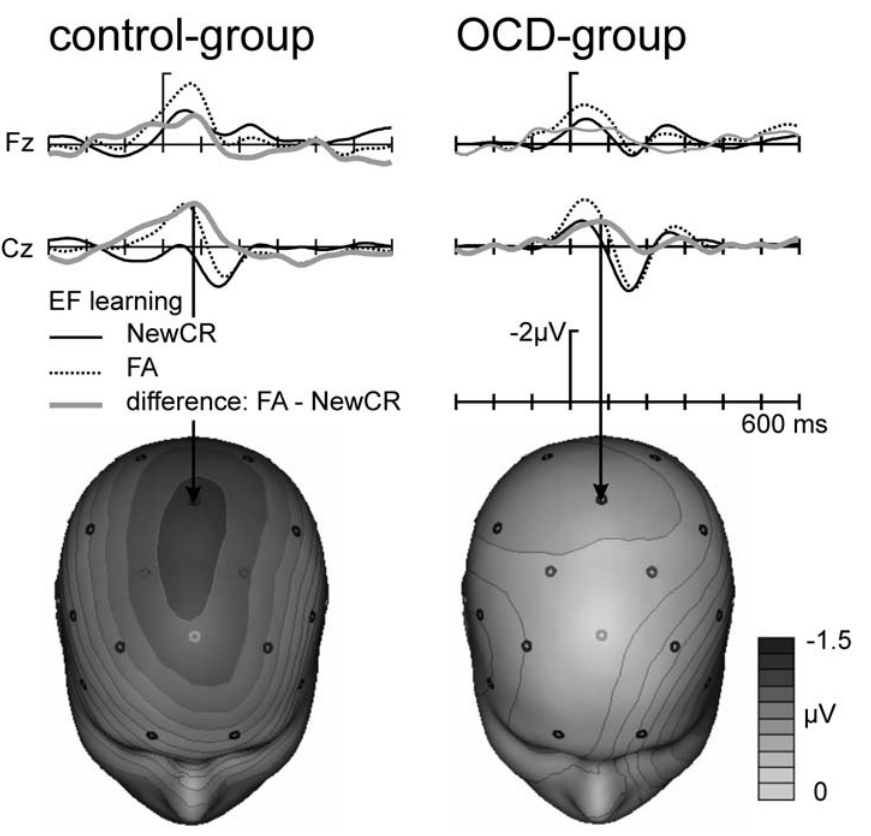
Figure 4. Difference waves of false alarms and correct rejections. Response-locked ERPs of false alarms in comparison to new correct rejection for the control (left panel) and OCD group (right panel). The grey line shows the difference wave of false alarm minus new correct rejections. The corresponding spline-interpolated isovoltage maps of the difference wave shows a fronto-central distribution for the control group. This effect is nearly absent for the OCD group.